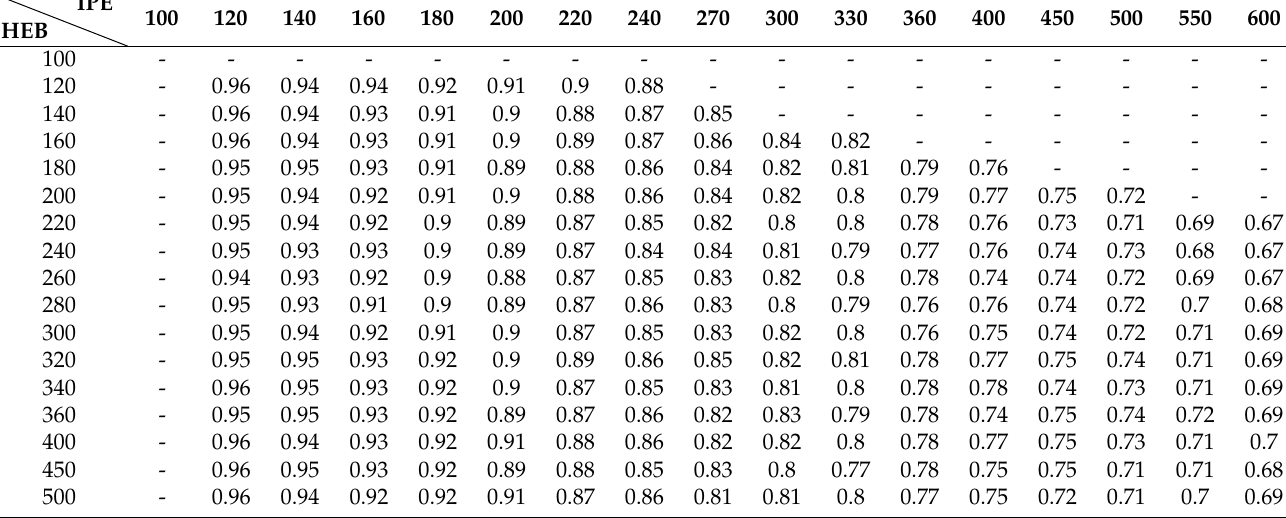
Table A1 lists the recommended anchor point of fixity-factor to start with. Table A1. Recommended anchor points of fixity-factor as